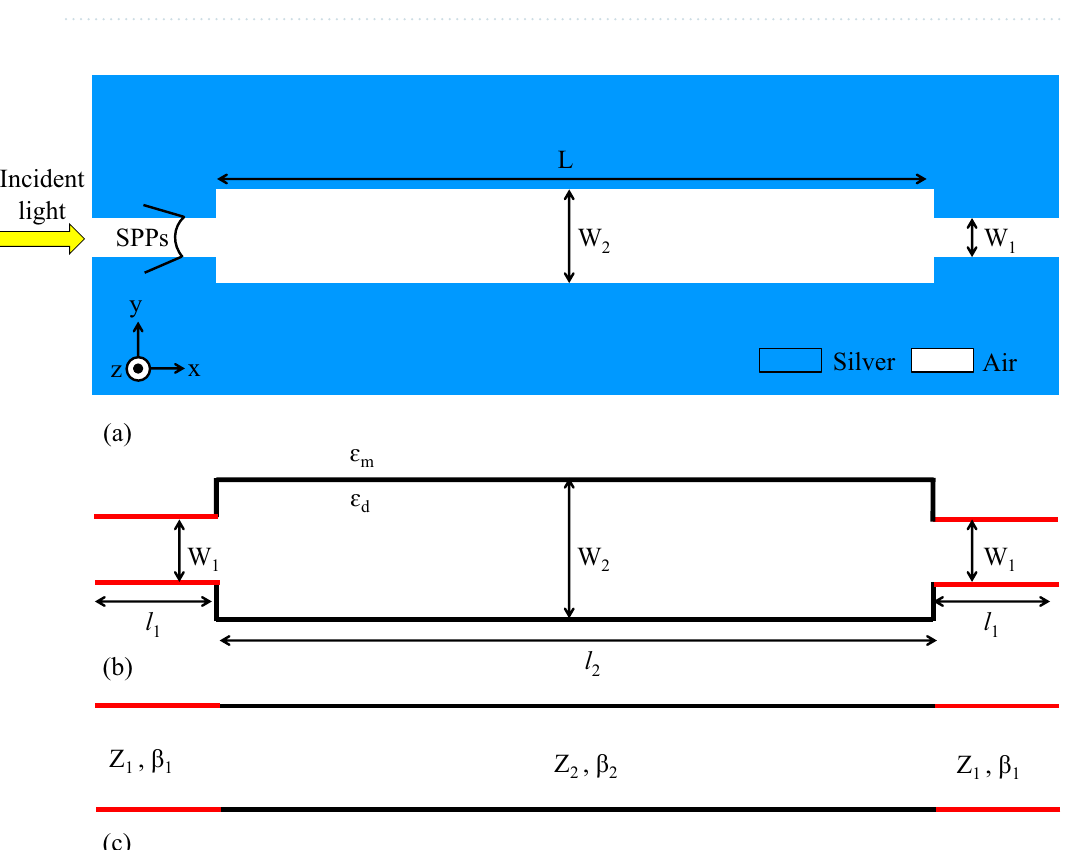
Figure 1. 3D topology of the initial structure.